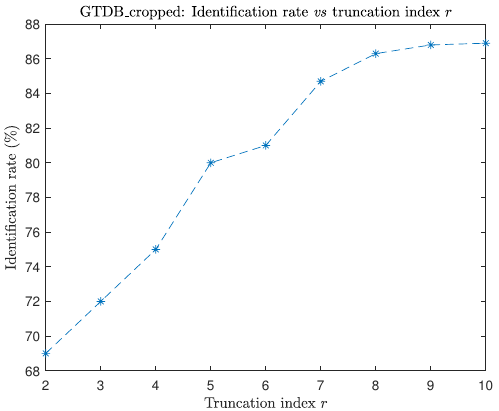
Figure 7. Identification rates for different truncation indices r